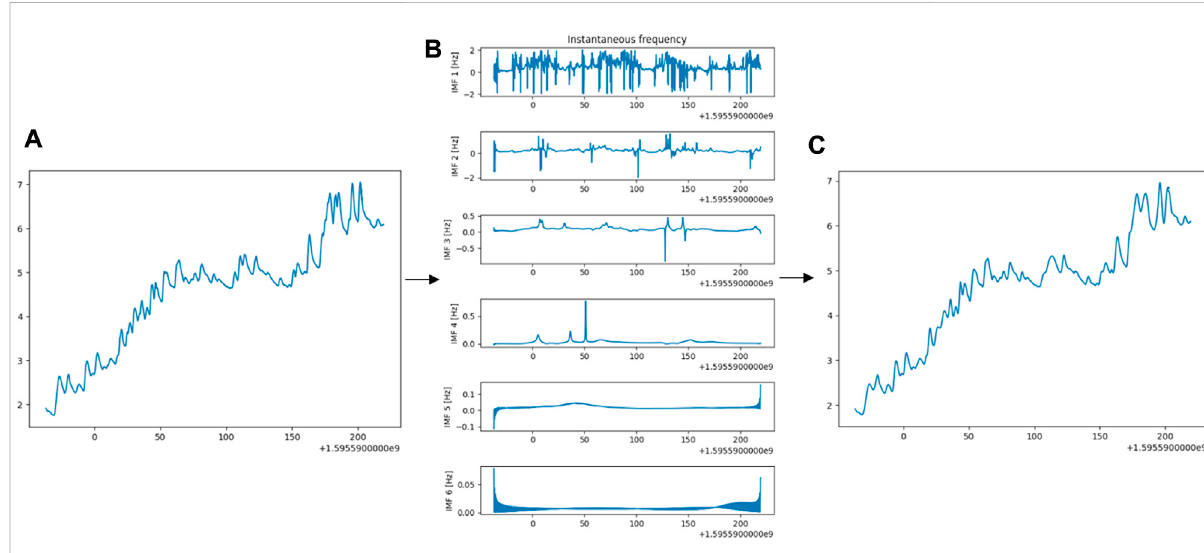
FIGURE 7 (A) OriginalGSRtimeseries (B) SixIMFsdecomposedbyEMD (C) OutputSeriesfromEMDontheoriginalsignal.Itisthesumofthelast fi veIMFs plus